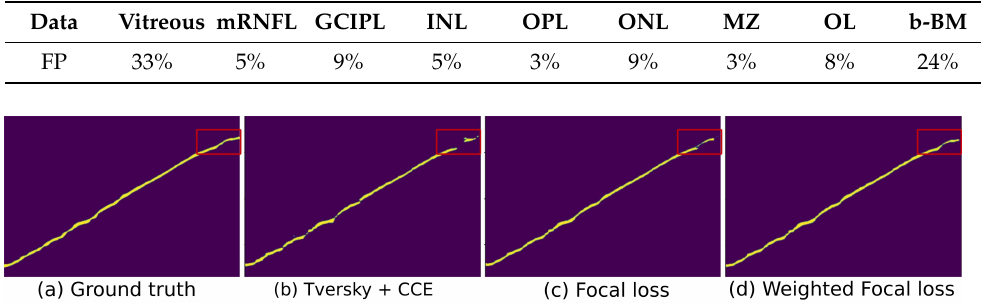
Table 1. Background and foreground pixel imbalance: the table shows the percentage of foreground pixels (FP) with respect to the total pixels in the training data for each class.